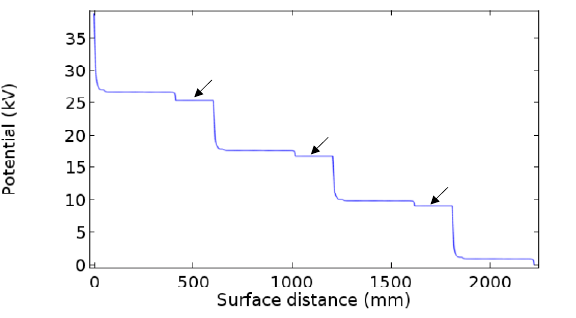
Figure 9. Potential distribution along insulator string.